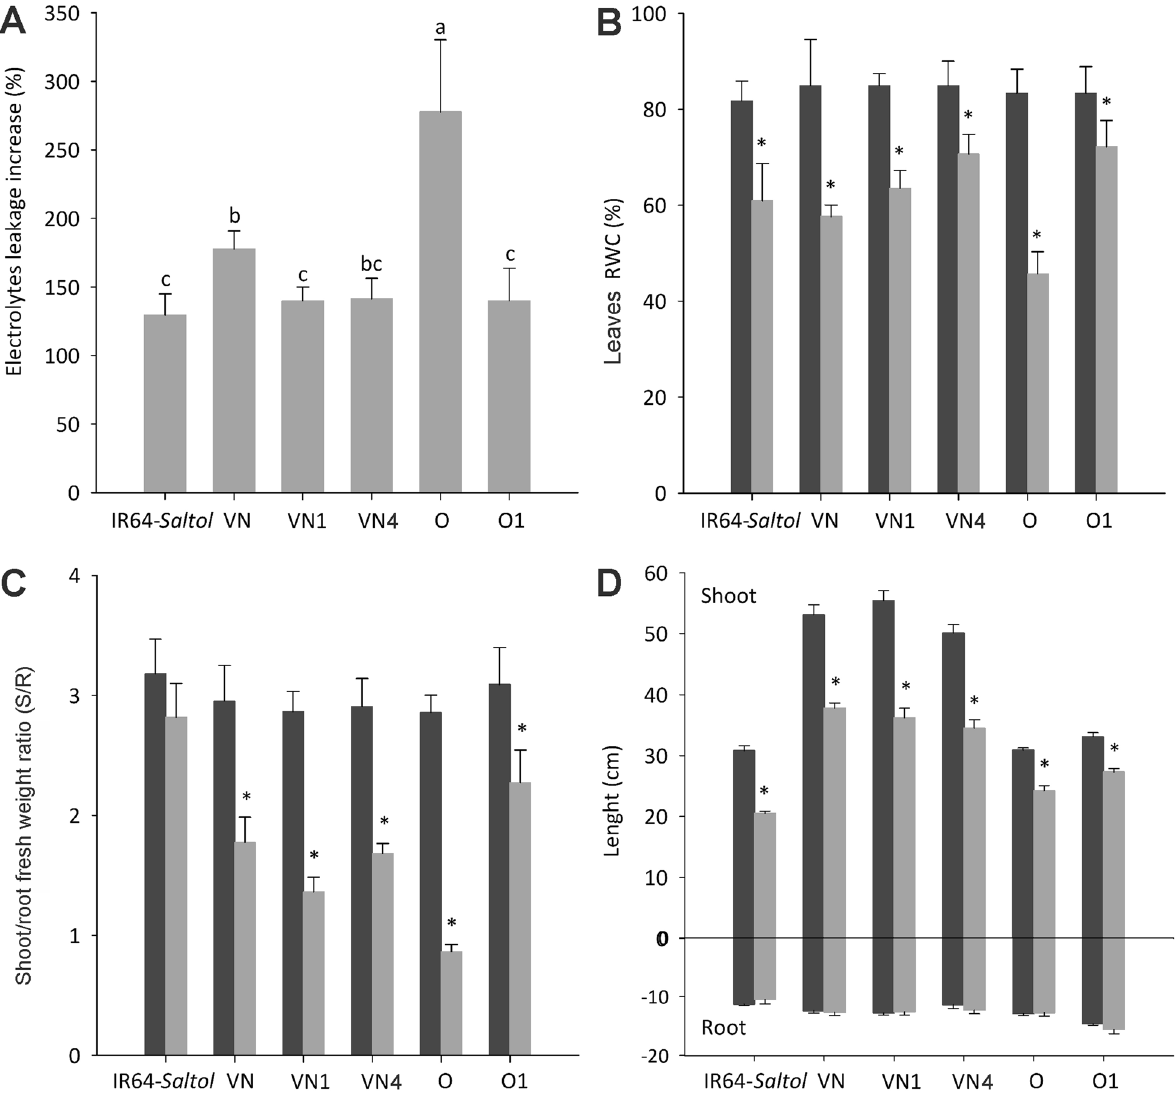
Fig. 6 Salt stress response parameters evaluated in tolerant parent IR64- Saltol , susceptible parents Vialone Nano (VN), Onice (O) and VN1, VN4, O1 introgression lines. Plantlets were grown for 7 days ( A Electrolyte leakage evaluation) or 14 days ( B Relative water content in leaves; C shoot/root fresh weight ratio; D shoot and root length) in modified Yoshida solution in the absence (blue columns, controls) or presence (orange columns) of 80 mM NaCl. Data are the means from three independent experiments (12 plants per genotype for each experiment); bars represent the SE values (n 36). Student’s t-test (* p < 0.05). Values with the same letter(s) are not significant at p < 0.05, as resulted by a Tukey post-hoc test with a Bonferroni =